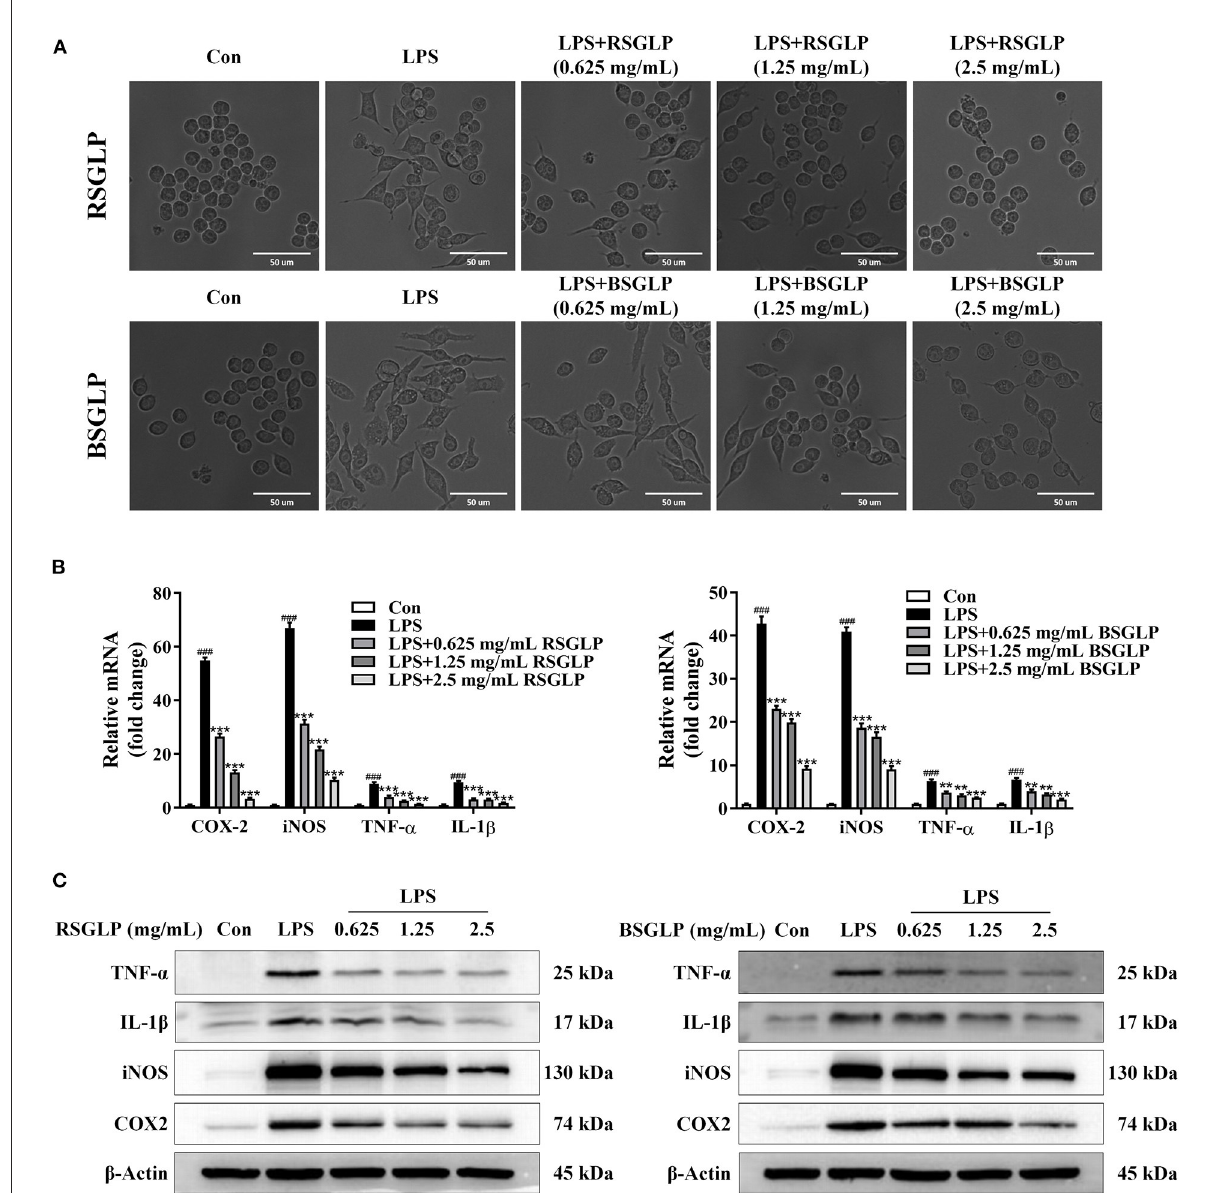
FIGURE8 Comparison of the effects of RSGLP and BSGLP on LPS-induced macrophage activation and inflammation in RAW264.7 cells. (A) Morphological alteration of RAW264.7 cells. (B) The expressions of inflammation-related genes iNOS, COX-2, TNF- α , and IL-1 β as determined using qRT-PCR. (C) The expressions of inflammation-related proteins iNOS, COX-2, TNF- α , and IL-1 β as determined using Western blotting. Cells were treated with LPS (1 µ g/mL) and GLP (RSGLP or BSGLP) at 0–2.5 mg/mL for 24h. Data are presented as mean ± SE from three independent experiments. *** p < 0.001, compared with LPS treatment group. ### p < 0.001, compared with Con